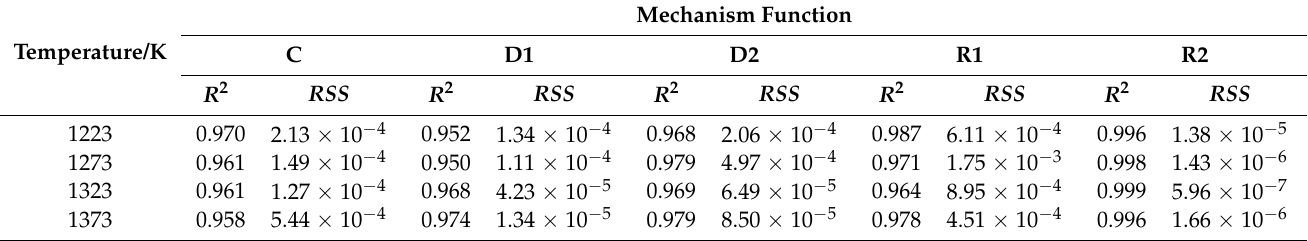
Table 5. Values of R 2 and RSS obtained from reduction ratios at 0–15